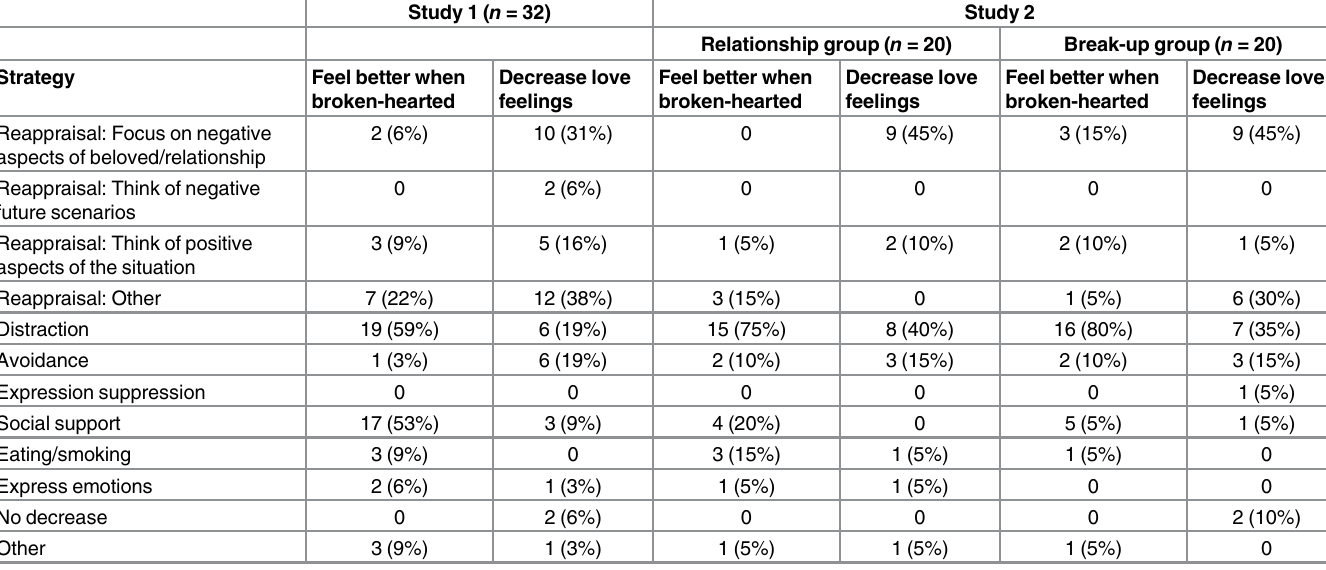
Table 1. Counts and percentages of participants reporting the use of certain regulation strategies in the context of heartbreak.